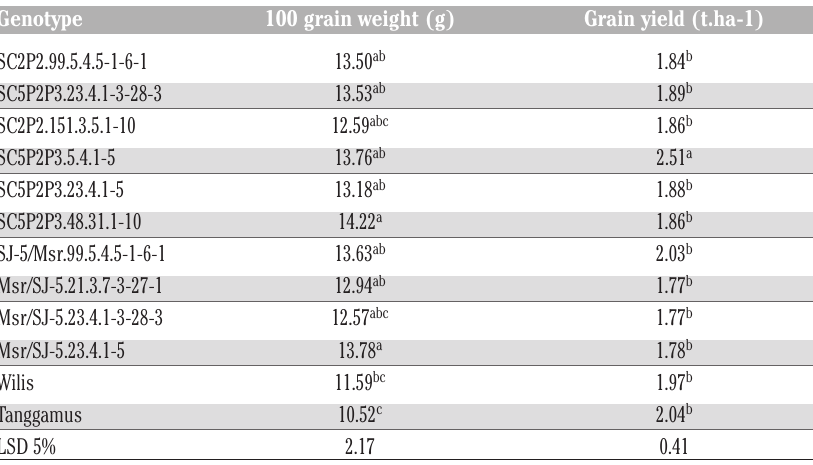
Table 5. Grain size (100 grains weight) and grain yield of acid-adaptive soybean promis- ing lines in Central Lampung, Indonesia.